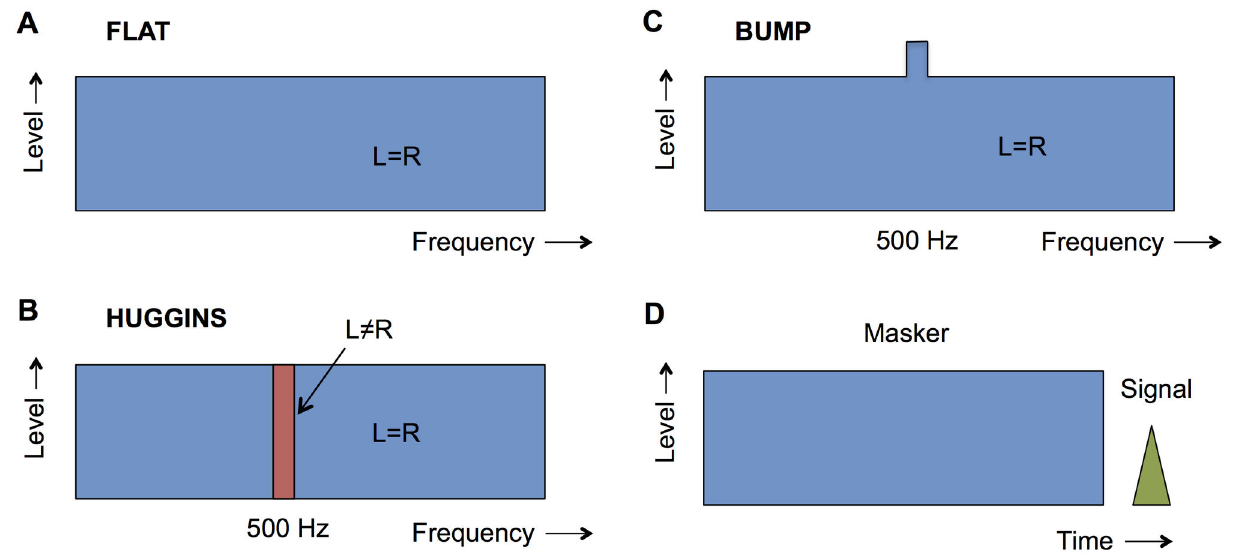
Figure 1. Stimuli. Schematic illustrations of the spectra of the masking noise for the Flat (A), Huggins (B), and Bump (C) conditions. “L” and “R” refer to left and right ears respectively. The decorrelated band (L≠R) for the Huggins stimulus is shown in red. D, A schematic illustration of the temporal characteristics of the stimuli. doi: